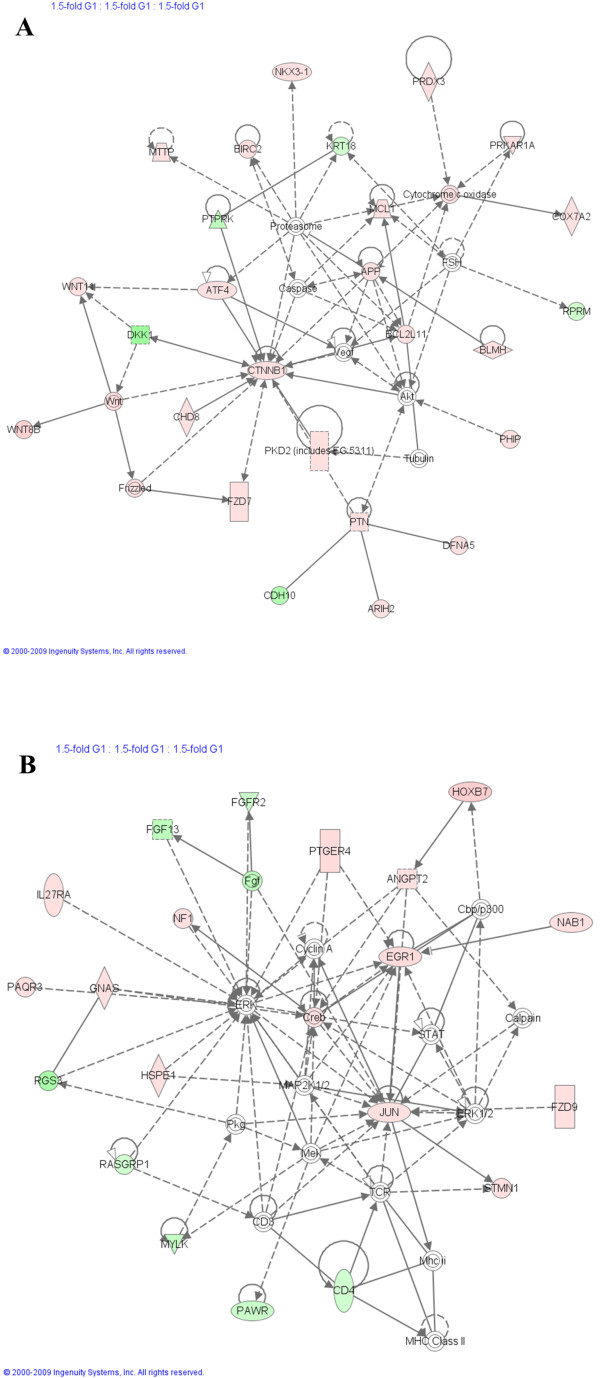
Ingenuity Pathway Analysis (IPA) on genes modulated by BaP in G1-enriched MCF7 cell cultures. Gene lists of 1.5-fold differentially expressed genes in different phases were imported to IPA software, which revealed the involvement of several pathways and genes in the response to BaP. Two networks are shown here. Red colour denotes up-regulation and green colour denotes down-regulation. The IPA legend is shown in Additional file 6.